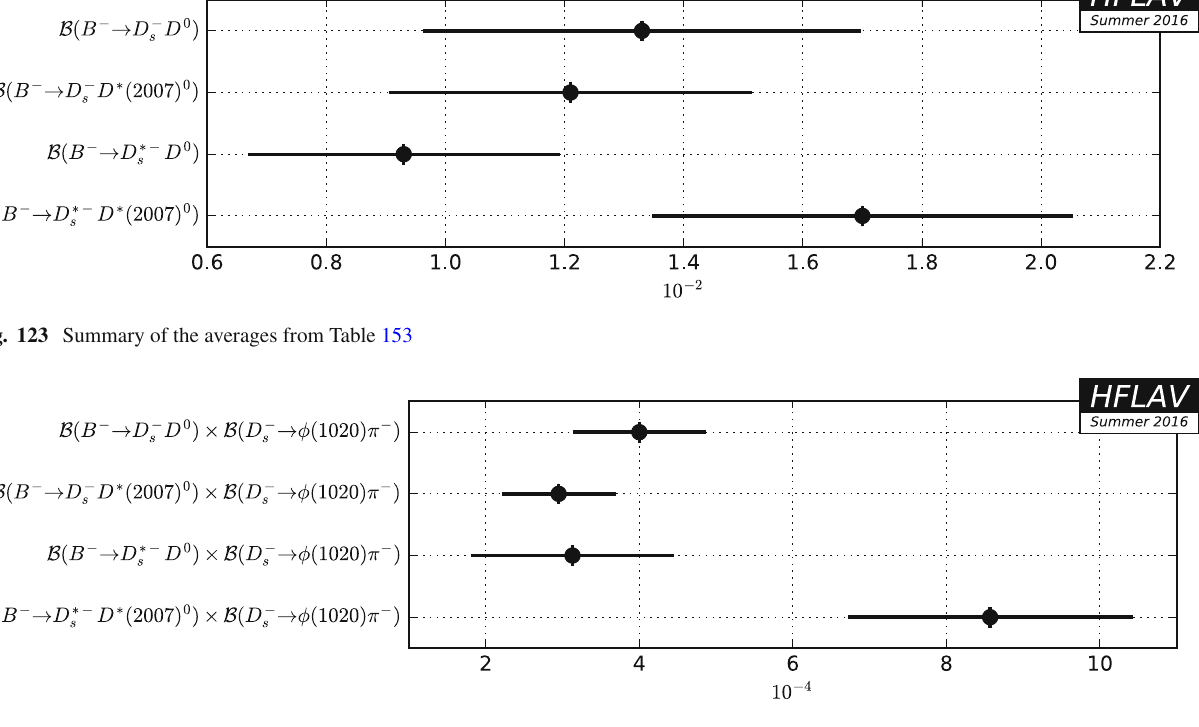
Fig. 124 Summary of the averages from Table 154